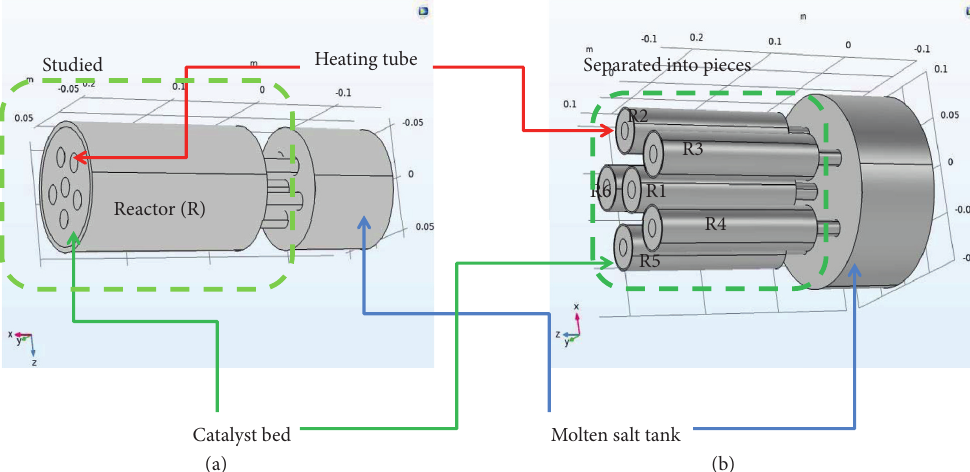
Figure 10: Realization of Figure 8 (especially dark dashed green box in Figure 10(b)) for six reactors based on the heat analysis results of Figure 9. Green-dashed box in (A) was studied in detail in this manuscript.